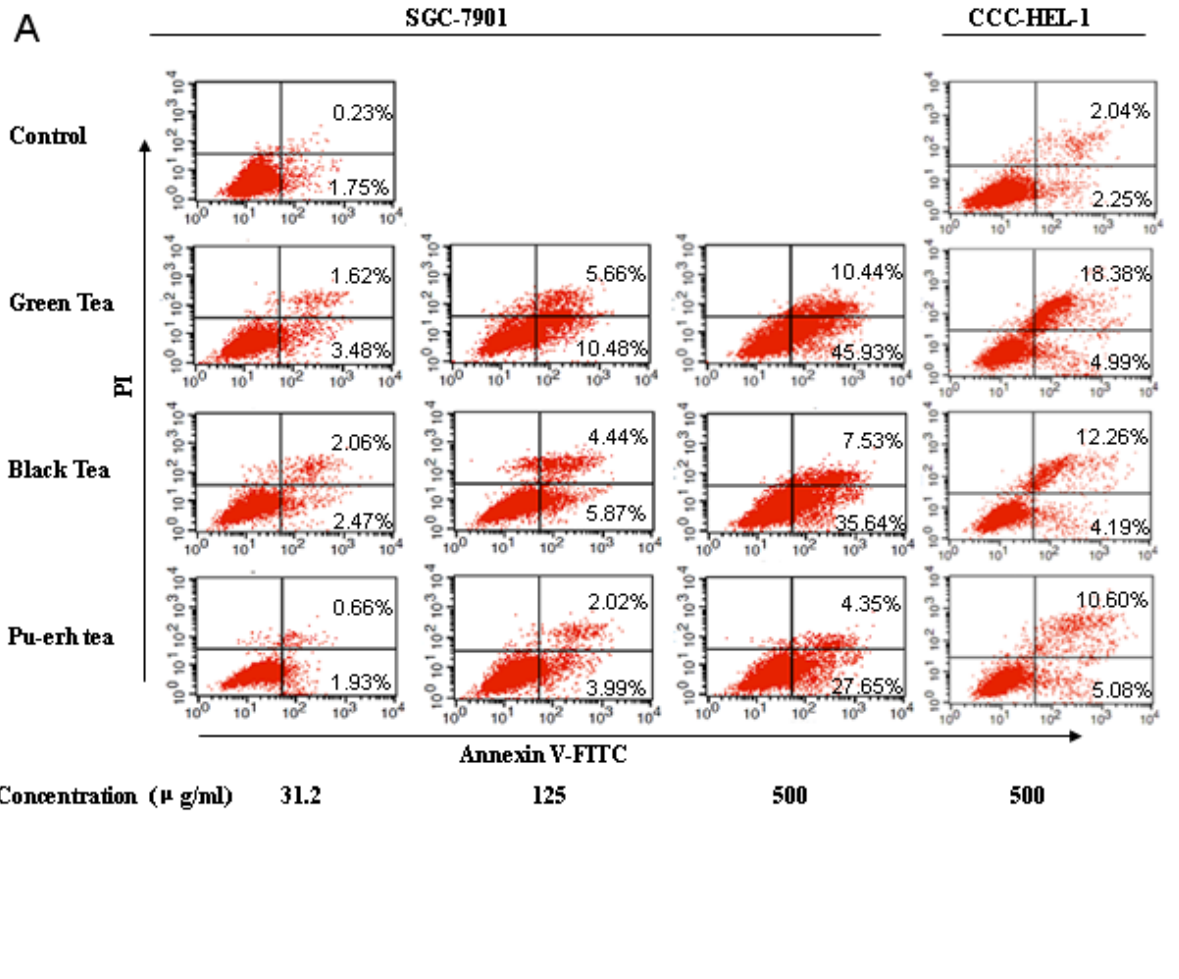
Figure 3. Flow cytometric analysis of cell apoptosis induced by treatment for 48 h in SGC-7901 and CCC-HEL-1 cells. ( A ) Apoptotic cells after treatment with three tea extracts at concentrations of 31.2, 125 and 500 μ g/mL in SCG-7901 cells and 500 μ g/mL in CCC-HEL-1 cells; ( B ) Apoptotic cells after treatment with tea constituents at the concentrations of 10, 50 and 250 μ g/mL in SCG-7901 cells and 250 μ g/mL in CCC-HEL-1